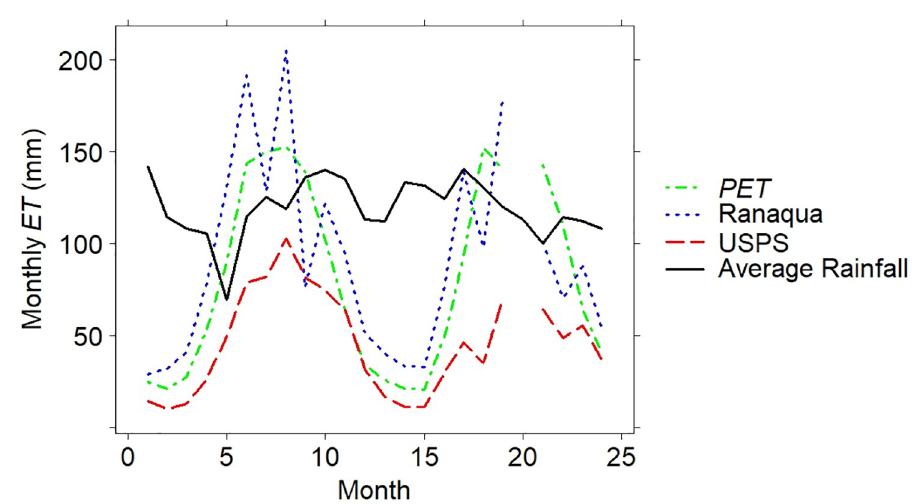
Fig 7. Monthly potential evapotranspiration (PET) and monthly evapotranspiration (ET) from both green roofs. Data are from December 2013 to November 2015, omitting July, 2015. Monthly rainfall from the Ranaqua weather station is drawn as a 6-month moving average in order to reduce noise from rainfall variability and more clearly demonstrate when PET and ET surpass average rainfall.